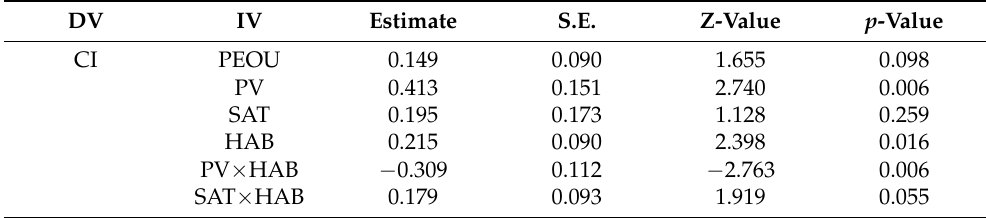
Table 8. Moderator